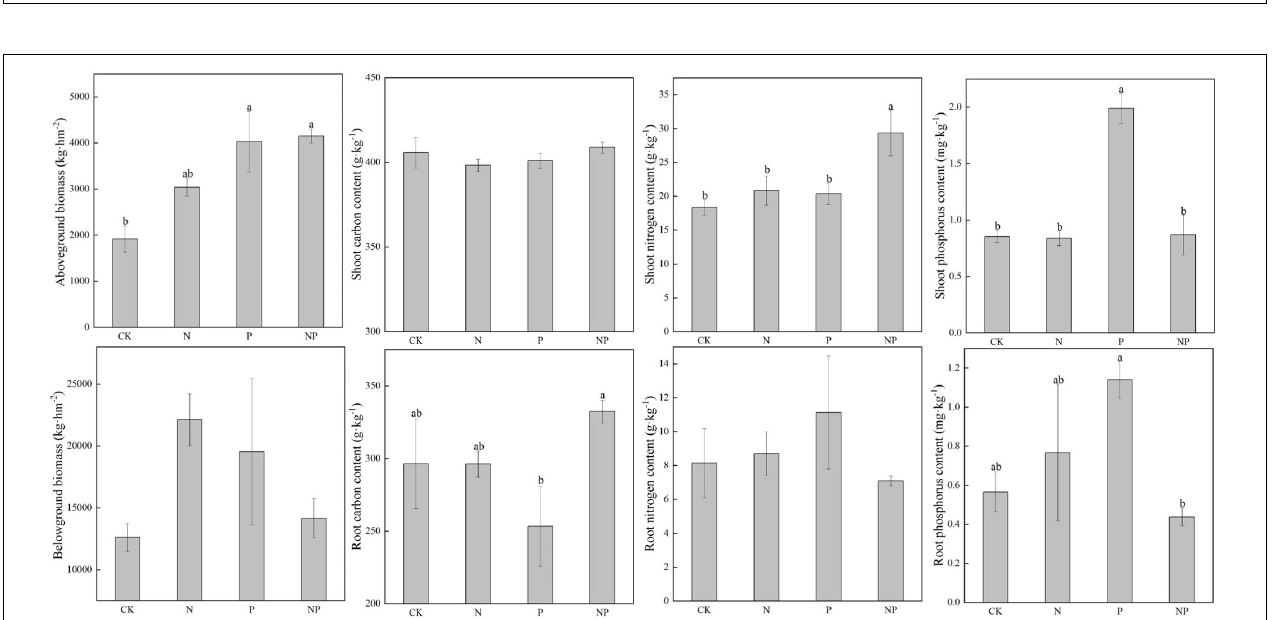
FIGURE 6 | Soil nutrients under different experimental treatments. Different letters indicate significant differences at a p < 0.05 level across experimental treatments. No letter indicates a non-significant difference (CK = control, N = addition of 72 kg N hm − 2 year − 1 , P = addition of 36 kg P hm − 2 year − 1 , NP = interaction of N and P).